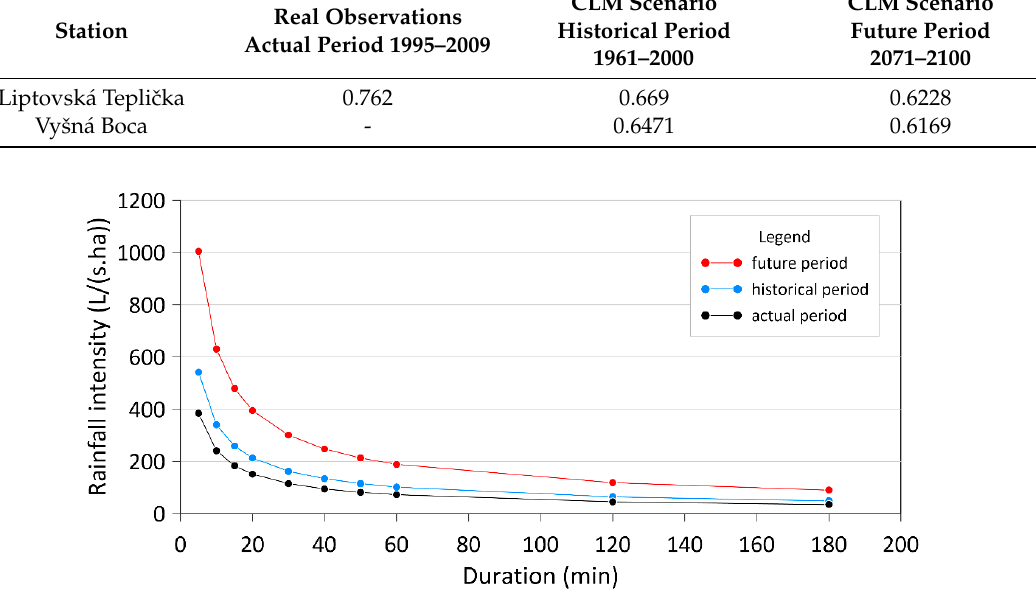
Figure 9. IDF curves for the Liptovsk á Tepliˇcka climatological station for the periodicity p = 0.01.